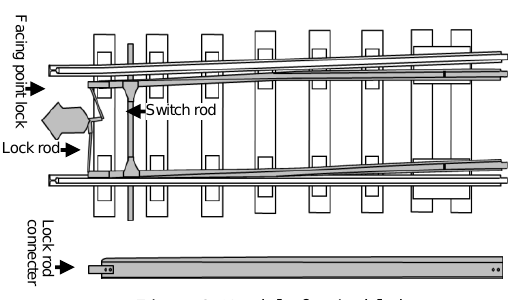
Figure 8. Model of point blade